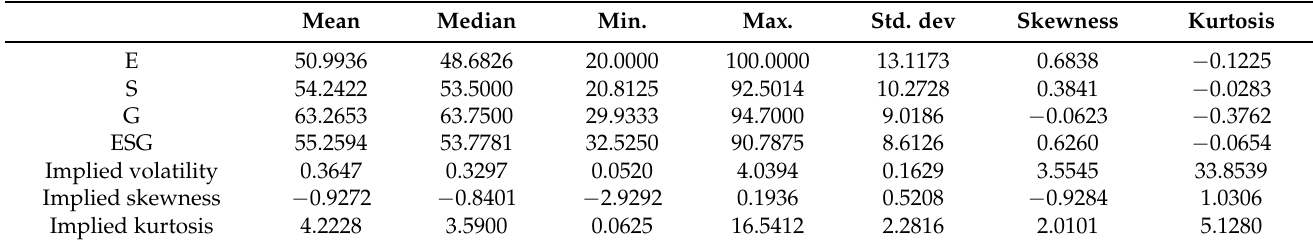
Table 1. Summary statistics of ESG ratings and implied